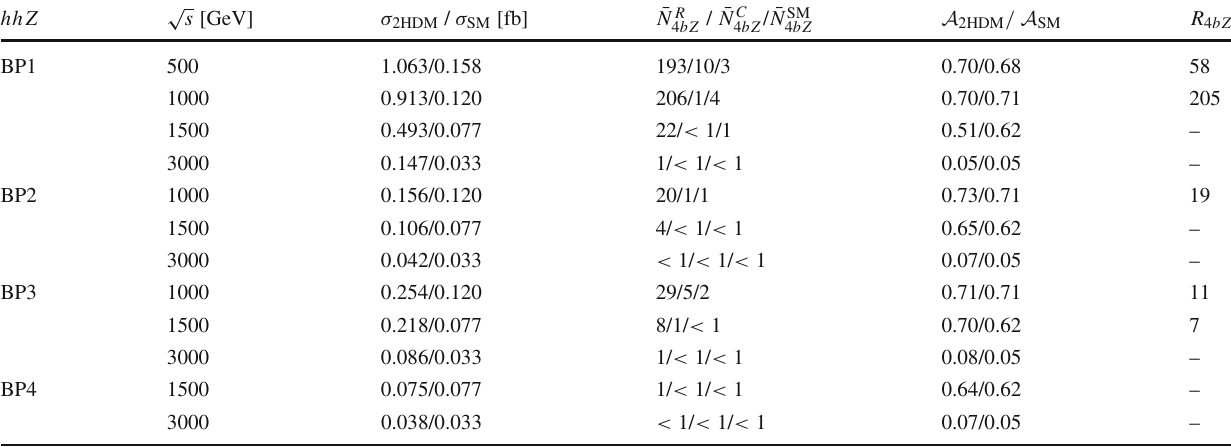
√ s . Also shown are total cross sections, σ , event numbers, ¯ N , and acceptances, A , in the 2HDM and the Table 5 R 4 bZ for the BPs at all relevant SM, as defined in the text. “–” indicates values that cannot be evaluated due to a too small number of events